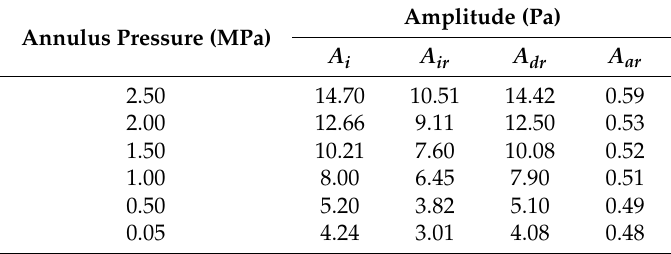
Table 2. Reflected pulse variation under different annulus pressures.